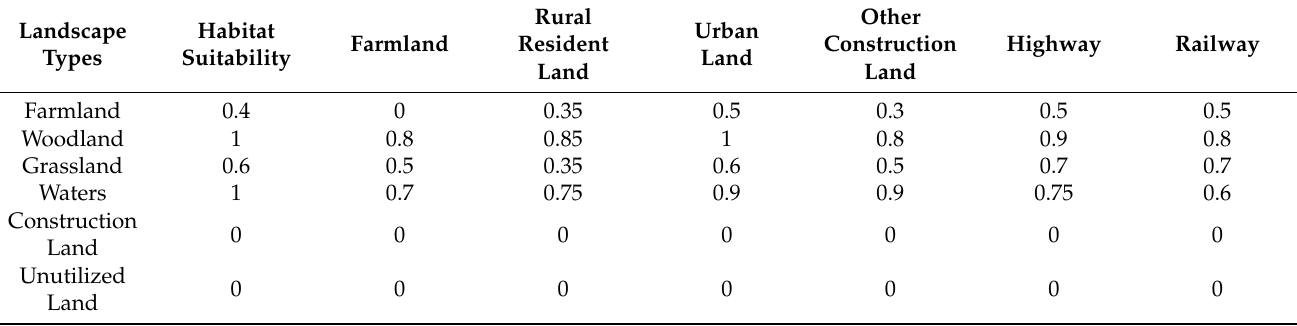
Table 2. Sensitivity of land-use types to each